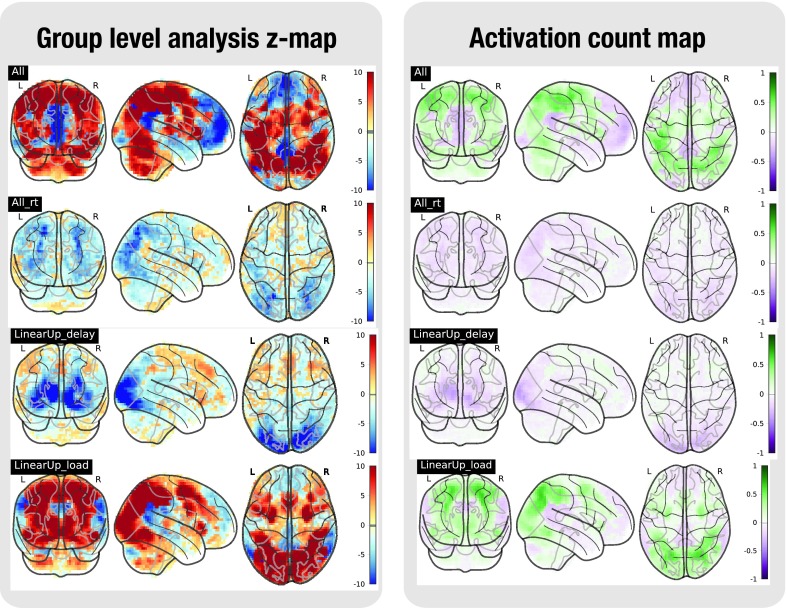
Task analysis results for the SCAP task.In the left plot, the statistical map of the one-sample group test, computed with randomise. The right plot shows the difference between the positive and the negative activation count maps.